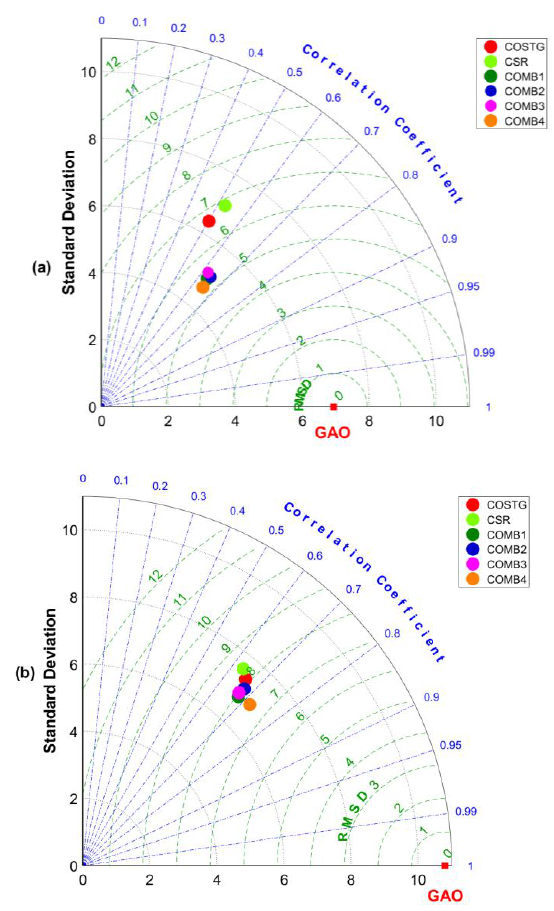
Figure 11. Taylor diagrams showing a comparison of non- seasonal χ 1 ( a ) and χ 2 ( b ) components of GAO (treated as a reference) with gravimetric excitation determined from a single GRACE/GRACE- FO solution (CSR), combined GRACE/GRACE-FO solution (COST-G), and the four combined solu- tions developed in this study (COMB1, COMB2, COMB3, and COMB4). The critical value of the correlation coefficient for non-seasonal variation for 55 independent points and a 95% confidence level is 0.22, and the standard error of the difference between the two correlation coefficients is